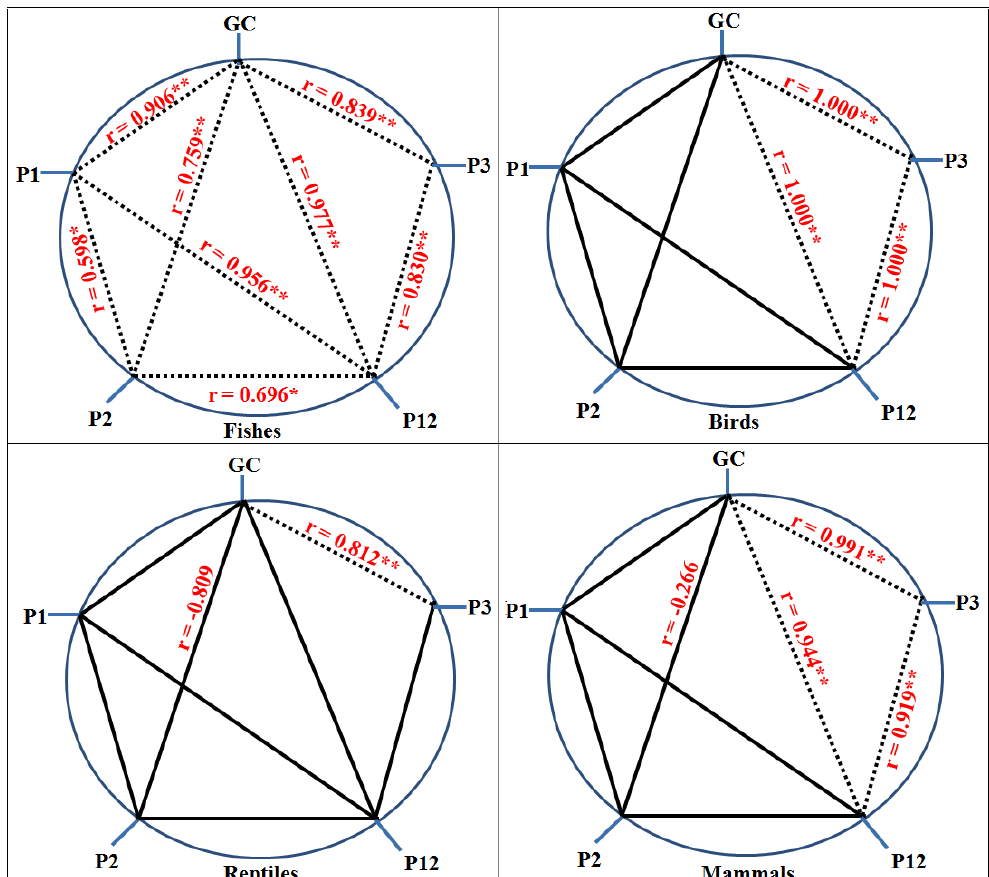
Figure 1. The correlation analysis between the mean value of GC contents and its different codon positions P1, P2, P3, and P12 for Foxp2 genes among fishes, birds, reptiles, and mammals. The dotted lines with asterisk (*) represents significant correlation while the line without dots represents no significant correlation detected in their Pairwise analysis. * p < 0.05 and ** p < 0.01.